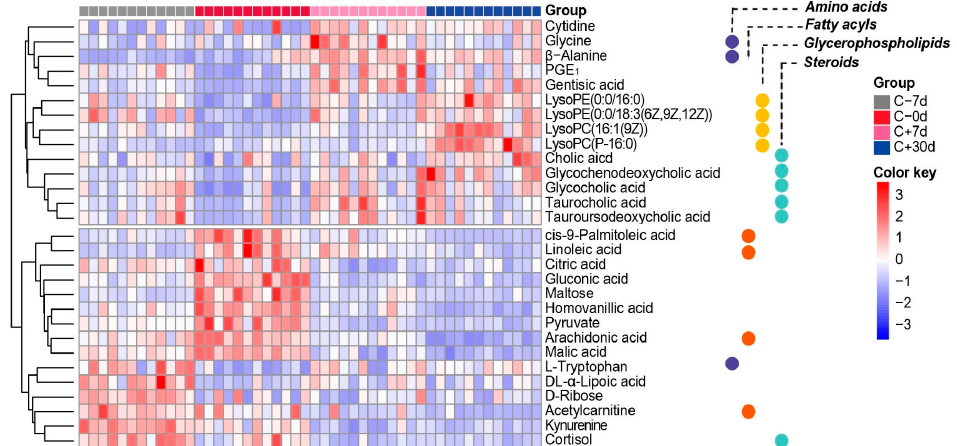
Figure 3. Heatmap demonstrating the dynamic changes in the plasma levels of 29 differential metabolites identified in control group cows at –7 d, 0 d, +7 d, and +30 d relative to calving. The heatmap color key represents the mean log (relative abundance of metabolite) and normalized efficacy values.